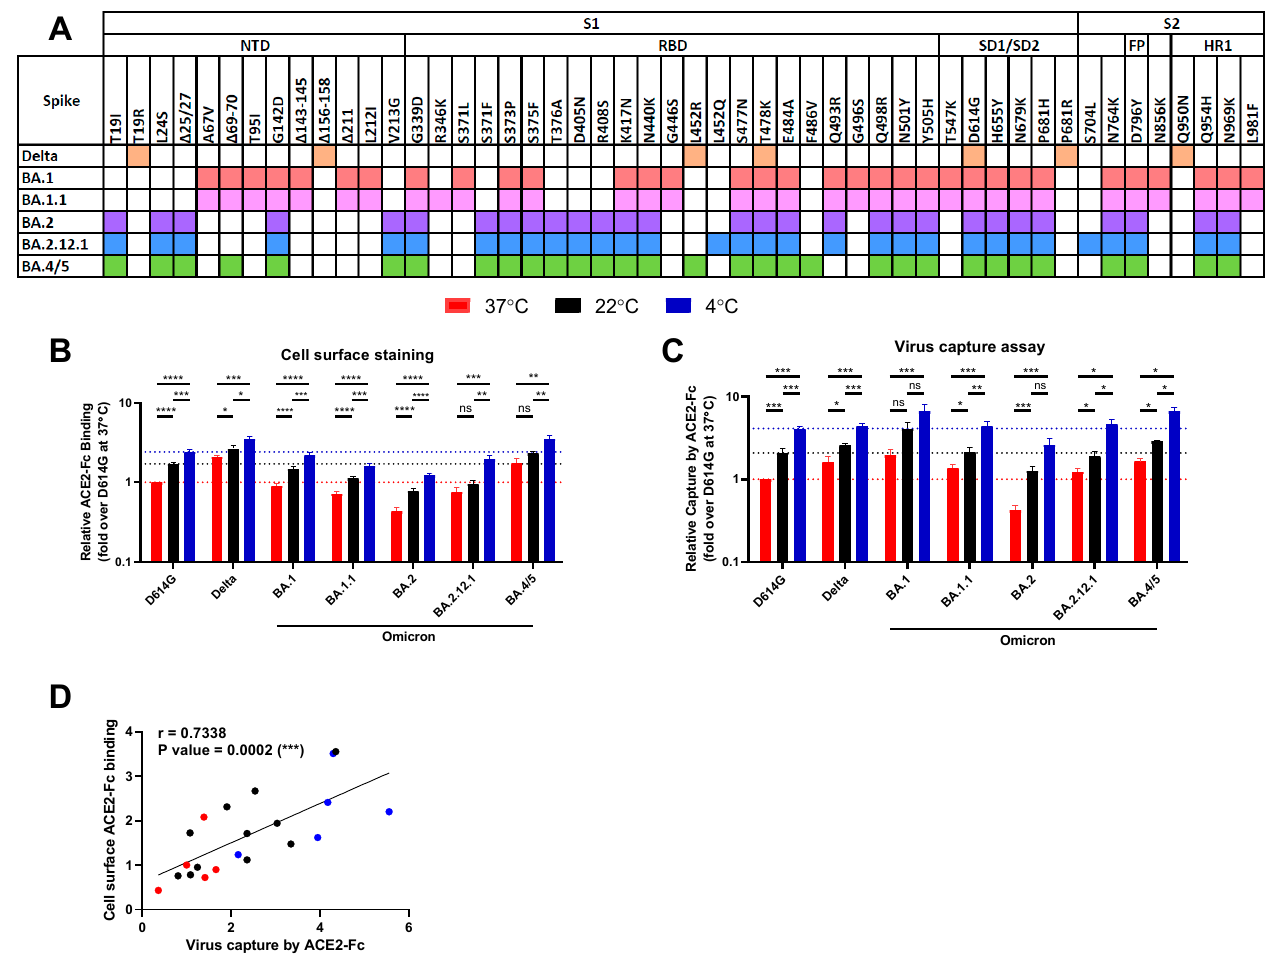
Figure 1. Low temperature enhances Omicron subvariant Spikes’ interactions with ACE2. ( A ) List of point mutations and deletions in the Spike amino acid sequence from Delta variant and Omicron subvariants compared to the D614G ancestral strain. NTD: N-terminal domain; RBD: receptor binding domain; SD1/SD2: subdomains 1 and 2; FP: fusion peptide; HR1: heptad repeat region 1. ( B-C ) Cell surface staining of transfected 293T cells and virus capture assay of Omicron and subvariant Spikes at 37 °C (red), 22 °C (black), and 4 °C (blue). ( B ) ACE2-Fc recognition is presented as a ratio of ACE2 binding to D614G Spike obtained at 37 °C. ( C ) Pseudoviruses encoding the luciferase gene (Luc+) and expressing the SARS-CoV-2 Spike D614G, Delta or from Omicron subvariants (BA.1, BA.1.1, BA.2, BA.2.12.1, BA.4/5) were tested for viral capture by ACE2-Fc at the respective temperatures. Relative light units (RLU) obtained using ACE2-Fc was normalised to the signal obtained with the temperature-independent CV3-25 mAb and presented as a ratio of ACE2 capture to D614G obtained at 37 °C. ( D ) Correlation between virus capture and cell surface binding of Spike by ACE2-Fc is depicted for the three temperatures tested. These results represent at least three independent experiments showing means ± SEM. Statistical significance was tested using ( B , C ) the Mann–Whitney U test or ( D ) Spearman rank correlation test (* p < 0.05; ** p < 0.01; *** p < 0.001, **** p < 0.0001, ns: non-significant).